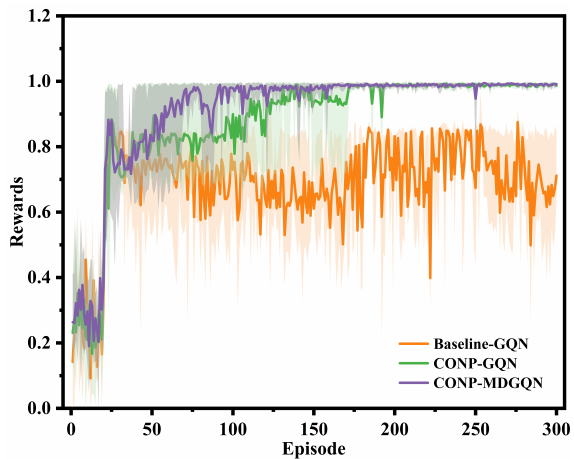
Figure 4. The comparison between the proposed reward function and